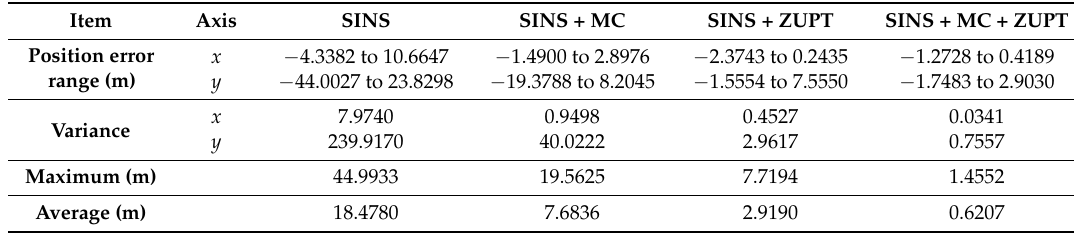
Table 2. Performance comparison for different integration models.